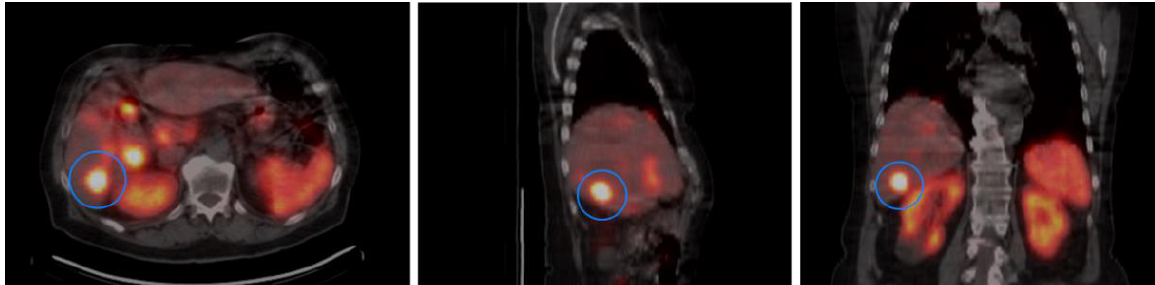
Figure 2. The activity concentration was calculated by using data from SPECT/CT imaging 24 h after the first PRRT treatment. Figure shows representative imaging in trans-axial, sagittal and coronal planes. The tumor lesion with the highest uptake is indicated.